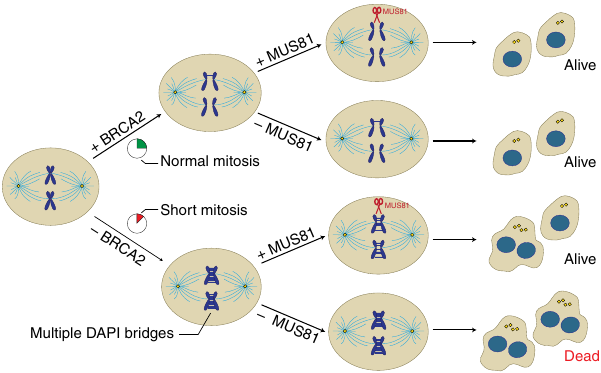
Figure 6 | Model for concerted action of MUS81 and BRCA2 during mitosis. BRCA2-proficient cells require MUS81 for cleavage of UFBs formed during mitosis at under-replicated CFS. In cells lacking BRCA2, incomplete DNA replication at multiple sites leads to DAPI-stained bridges detectable in anaphase as chromosome interlinks. MUS81 is required to resolve these bridges and to promote mitotic DNA synthesis, ultimately facilitating chromosome segregation. MUS81 inactivation in BRCA2-deficient cells leads to persistent chromosome interlinks, multinucleation, supernumerary centrosomes and cell death. Blue, sister chromatids; yellow, centrosomes; light blue,